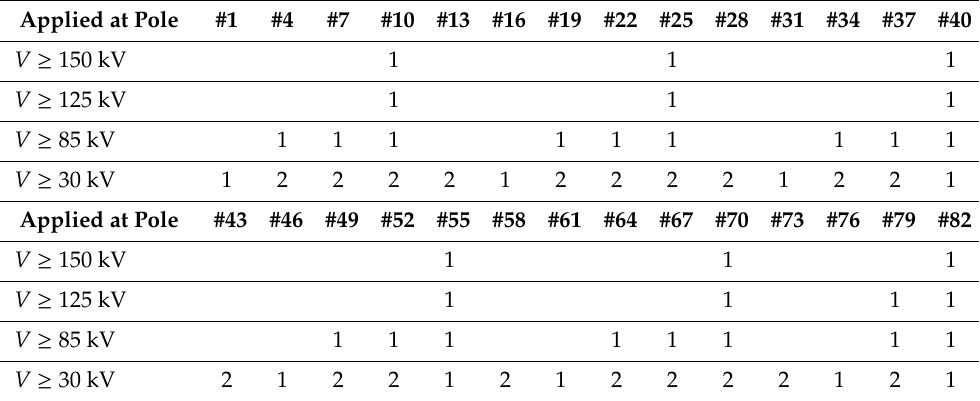
Table 6. Number of transformers with at least one phase reaching the critical overvoltage level. Case 2, wet arsenic-impregnated poles and grounding one intermediate pole between two transformer poles.